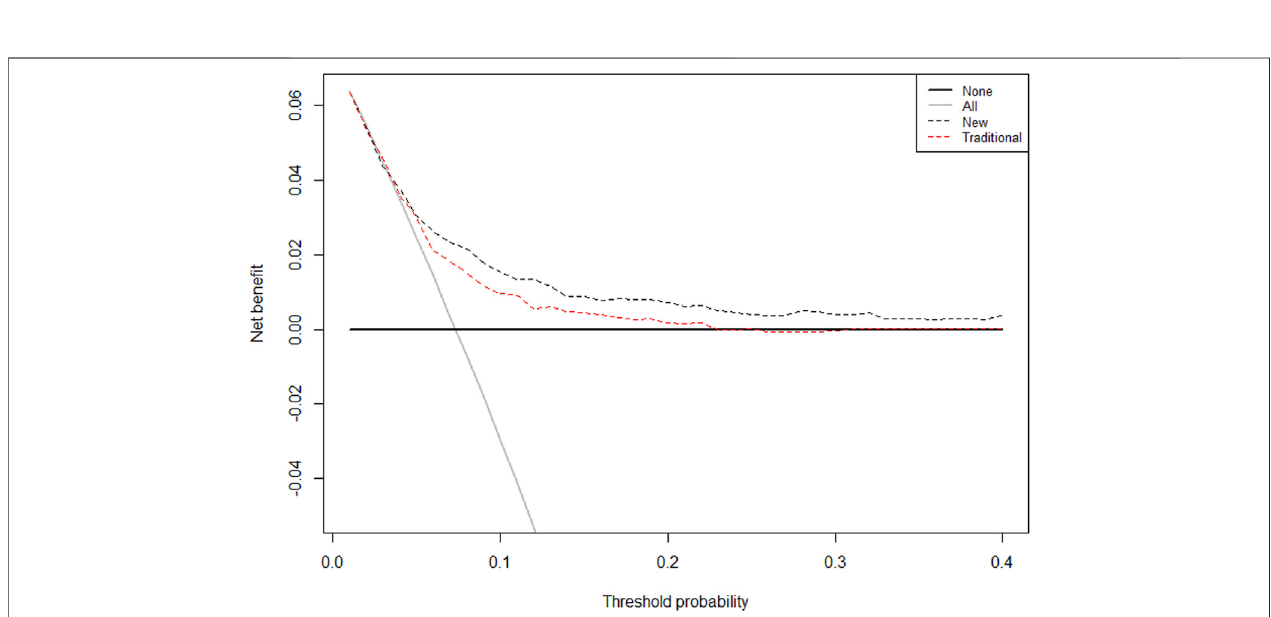
FIGURE 7 | The Decision Curves Analysis (DCA) curve of the prognostic nomogram for predicting probability of overall survival at 5 years. Note: The traditional group-composed by parameters of age, sex, hypertension, diabetes, CHOL, HDLC, BMI, smoking, TRIG; Novel group: age, HF, FT3/FT4, ALB, and proBNP. The horizontal axis represents the threshold value, which is the reference probability of whether a patient receives treatment, and the vertical axis represents the net bene fi t rate after the advantages minus the disadvantages. Under the same threshold probability, the larger net bene fi t implies that patients can obtain the maximum bene fi t using the diagnosis of this model. The closer the curve in the DCA graph is to the top, the higher the value of the model diagnosis will be.